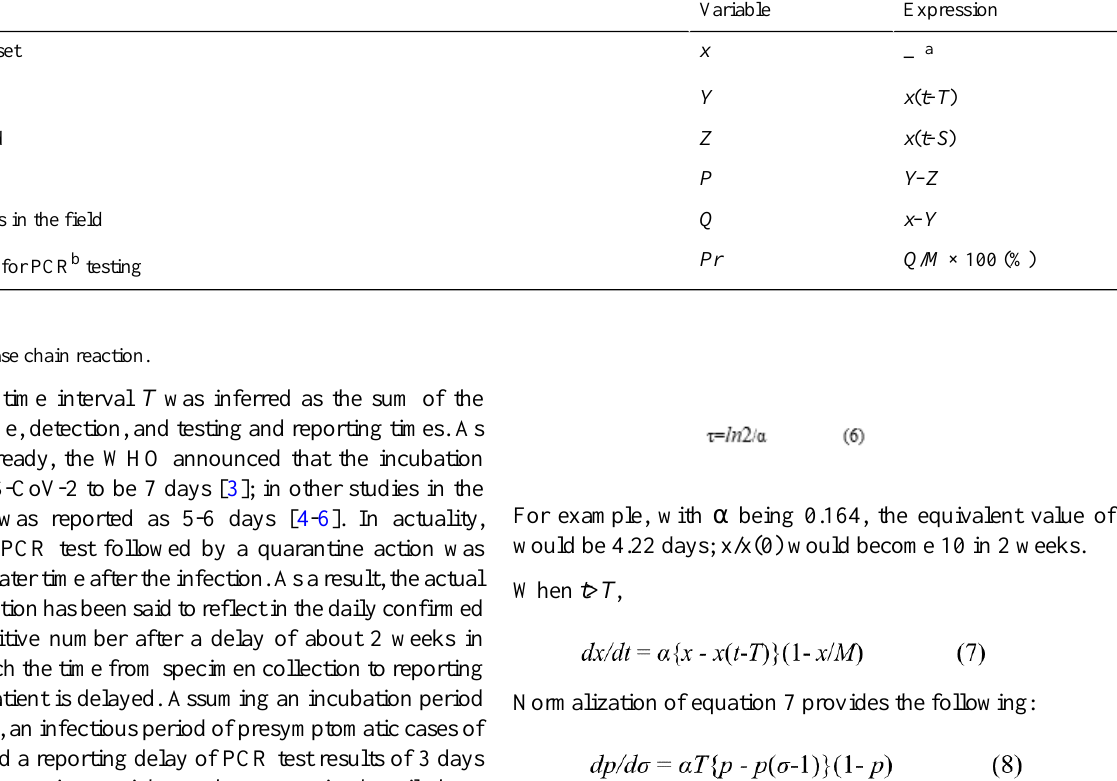
Table 1. Expressions for infection variables in terms of cumulative infections x.